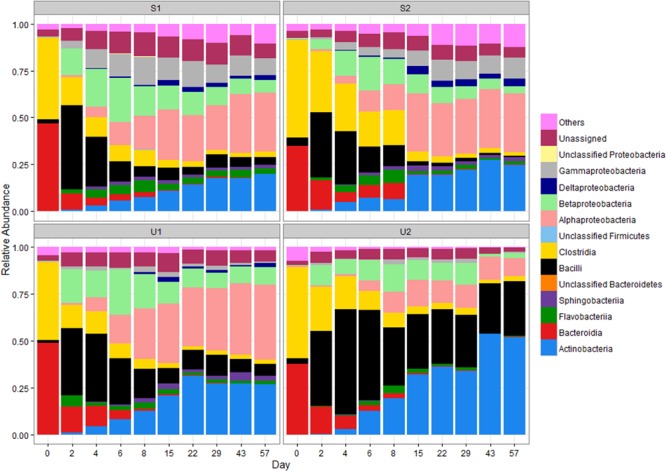
Relative abundance (RA) of bacterial classes in shaded (S) and unshaded (U) samples from farm 1 and 2. The RA is calculated by averaging abundances of two individual cowpats. “Others” includes all classes with less than 0.5% RA. NA, not assigned.